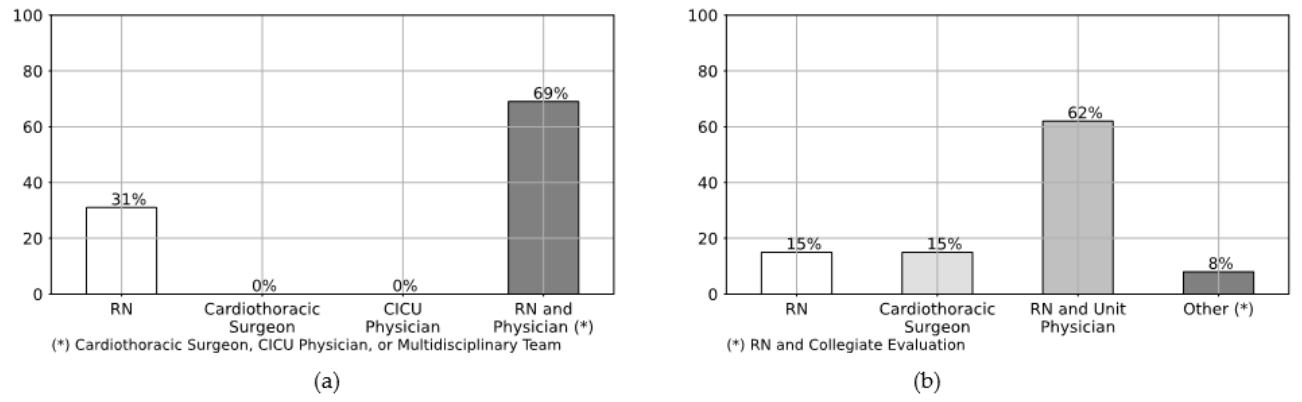
Figure 2. Monitoring and dressing management of the cardiac surgical wound. ( a ) Staff member in the CICU who is responsible for monitoring and dressing management. ( b ) Staff member who is responsible for monitoring and dressing management in case of patient’s transfer to another ward.